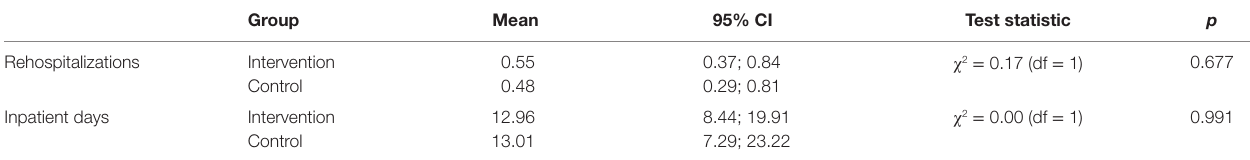
TaBlE 2 | number of rehospitalizations and total inpatient days at 12-month follow-up according to clinical registry records (primary outcomes).